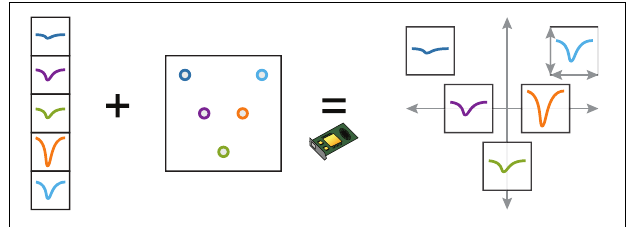
FIGURE 4 | Dynamic representation of multielectrode extracellular spike wavefoms with the probe geometry. This example illustrates how a complex arrangement of spike waveforms can be efficiently implemented on the GPU with a vertex shader. The user can smoothly change the local and global scaling of the waveforms. The normalized waveforms, as well as the probe geometry, are loaded into GPU memory at the beginning of the session. The vertex shader applies translation, local and global scaling transformation on the waveform vertices, depending on user-controlled scaling